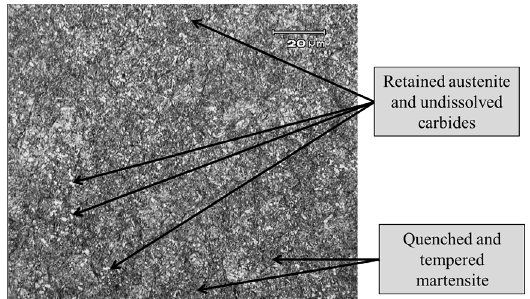
Figure 4: Microstructuer of martensitic stainless steel DIN 1.4110 after quenching by conventional heat treatment and tempering at 250 °C for 1.5 h.